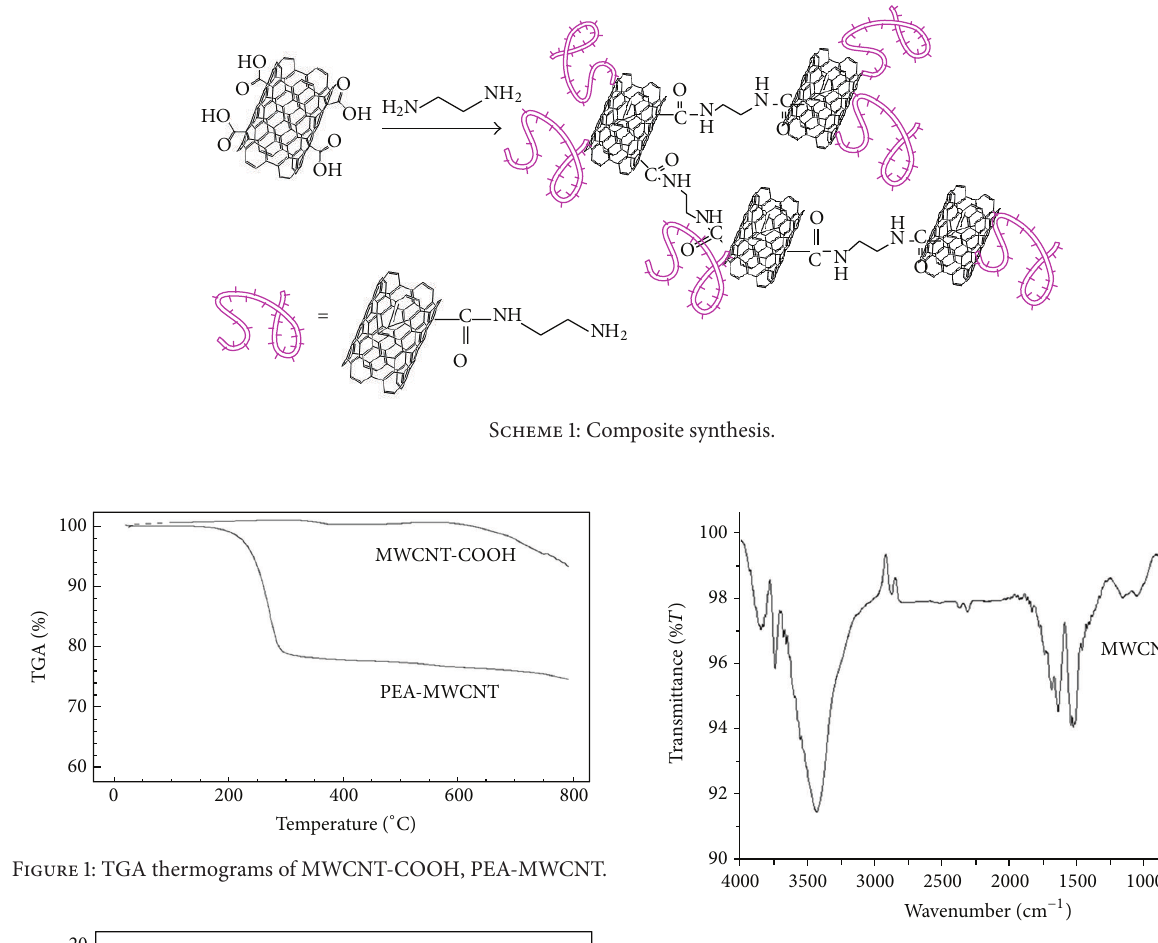
Figure 3: Fourier transform infrared (FTIR) spectra of MWCNT-